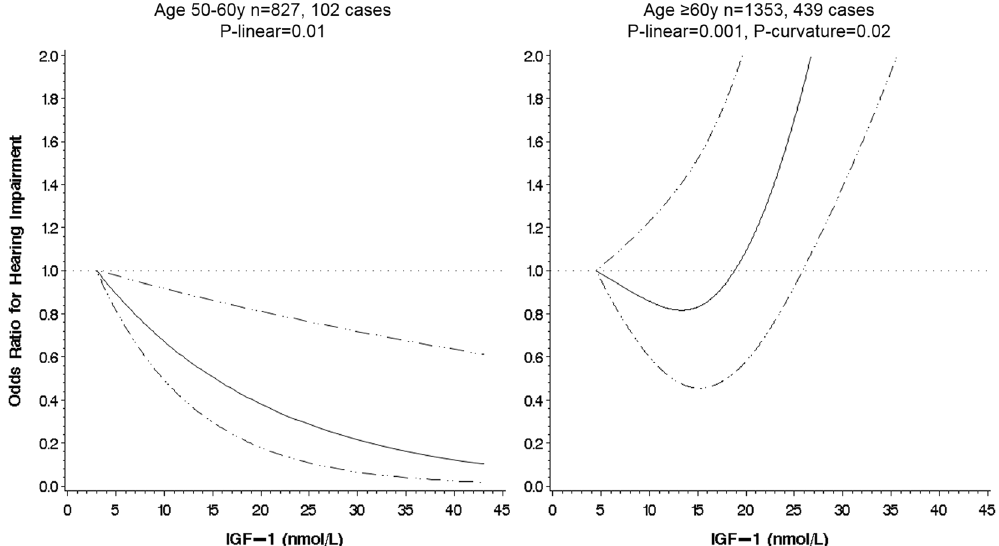
Figure 3. Serum Insulin-like Growth Factor-1 and odds of hearing impairment, by age group, after exclusion of self-reported mild to severe hearing impairment at baseline, the English Longitudinal Study of Ageing. Association estimated by logistic regression based on restricted cubic splines, the reference value is the minimum. Dashed lines indicate the 95% CIs. The model was adjusted for age, sex, height, smoking status, BMI, cognitive function (baseline and change), educational level, physical activity, self-rated poor health (baseline and change), and self-rated hearing acuity at